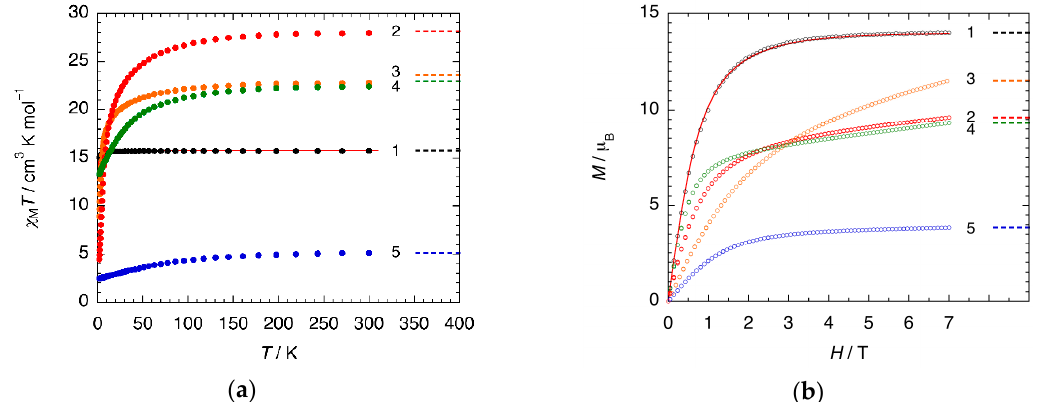
Figure 2. ( a ) Temperature dependence of the molar magnetic susceptibility times the temperature for 1 – 5 over the temperature range between 1.8 and 300 K under an applied dc field of 0.1 T; ( b ) Field dependence of molar magnetization for 1 – 5 over the dc field range between 0 and 7 T at 1.8 K. The broken lines correspond to ideal free-ion values. The solid red lines represent fits to the experimental data using the spin Hamiltonian based on the zero-field splitting, which has been previously described in detail [23].